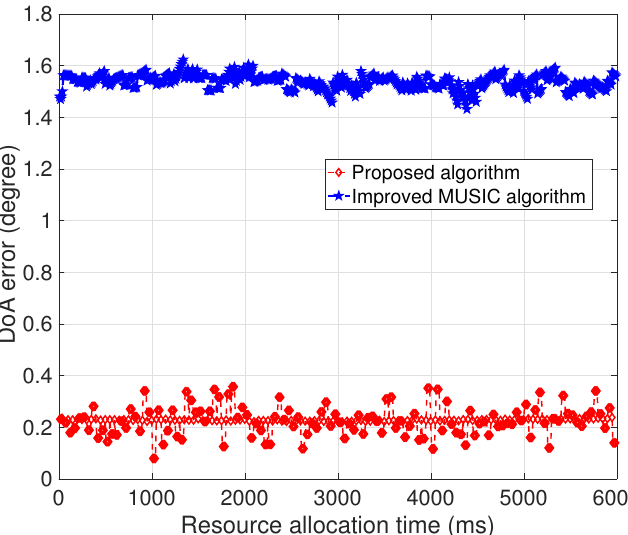
Figure 8. DoA estimation errors of the proposed and the improved MUSIC algorithms for UAV’s random walk flight